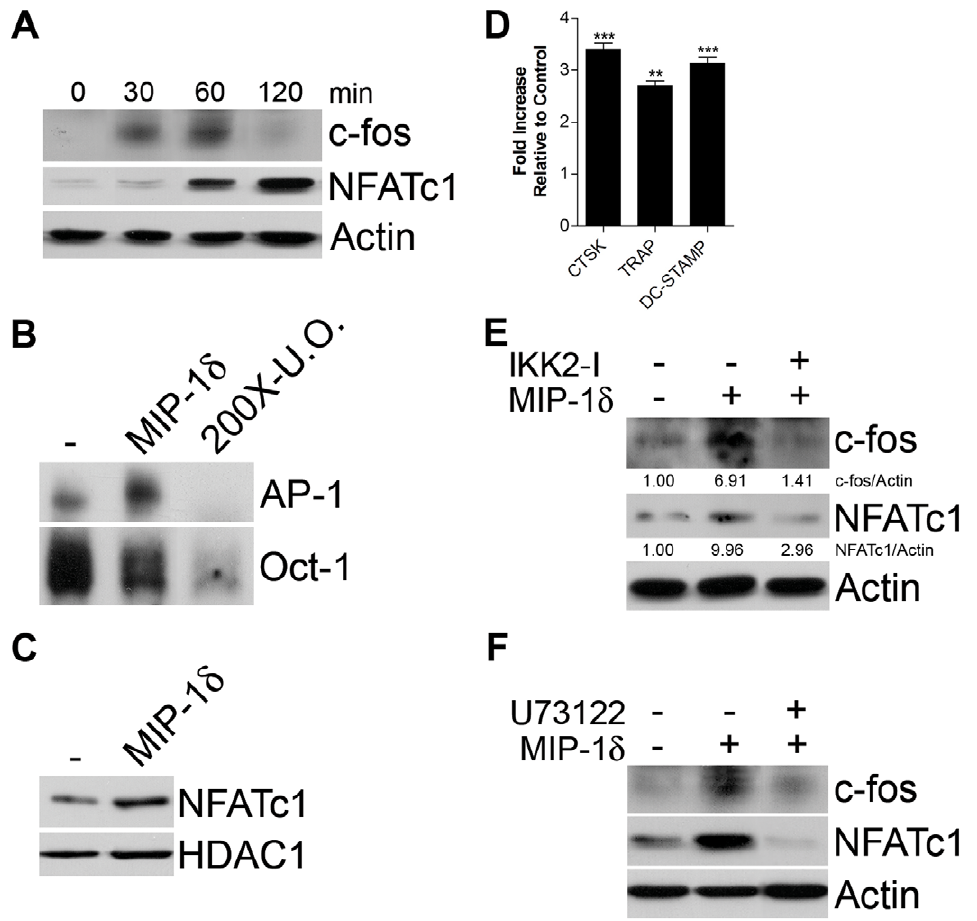
Figure 3. MIP-1 d induces expression and activity of c-fos and NFATc1 via stimulation of the PLC c 2 and NF- k B signaling pathways. BMM were treated with or without MIP-1 d (0.1 pg/ml). (A) c-fos and NFATc1 protein expression were determined by Western analysis performed on equal amounts of protein from total cell lysates. (B) Activation of AP-1 was determined 30 minutes following treatment with MIP-1 d by non- radioactive EMSA analysis of nuclear cell lysates using AP-1 oligonucleotides. Oct-1 served as a loading control and 200-fold excess unlabeled oligonucleotide (200X-U.O.) served as a competitive control. (C) NFATc1 protein expression was determined 60 minutes following treatment with MIP-1 d by Western analysis performed on equal amounts of protein from nuclear cell lysates. (D) CTSK, TRAP, and DC-STAMP mRNA expression were determined by qRT-PCR 24 hours following treatment with MIP-1 d . Data are representative of three independent experiments performed in triplicate, expressed as the mean (n =9) 6 s.e.m, and were analyzed by unpaired, two-tailed Student’s t-test. p , 0.01; ***, p , 0.001. (E, F) BMM were treated with MIP-1 d (0.1 pg/ml) alone or in combination with the (E) NF- k B inhibitor IKK2 inhibitor VIII (IKK2-I) or the (F) PLC inhibitor U73122 and protein expression was determined 60 minutes (c-fos, NFATc1) or 30 minutes (I k B a , phospho-PLC c 2) following MIP-1 d treatment by Western analysis performed on equal amounts of protein from total cell lysates. (E) Densitometry values are provided below respective lanes for ease of interpretation. Data are representative of at least two independent experiments. (P/S) using a 27 gauge needle. Cells were washed and re- suspended in complete media ( a MEM + 10% FBS + 1% P/S) containing 5 ng/ml M-CSF (R&D Systems, Minneapolis, MN) and incubated in a 100 mm dish overnight. Non-adherent cells were then collected, strained through 70 m m nylon mesh, and treated with 50 ng/ml M-CSF for 3 days to generate M-CSF- dependent bone marrow macrophages (BMM).